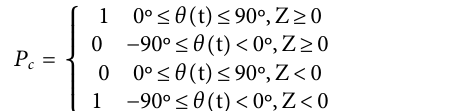
different polarization migration interfaces is stacked, and the maximum value of stacked energy denotes the correct velocity.